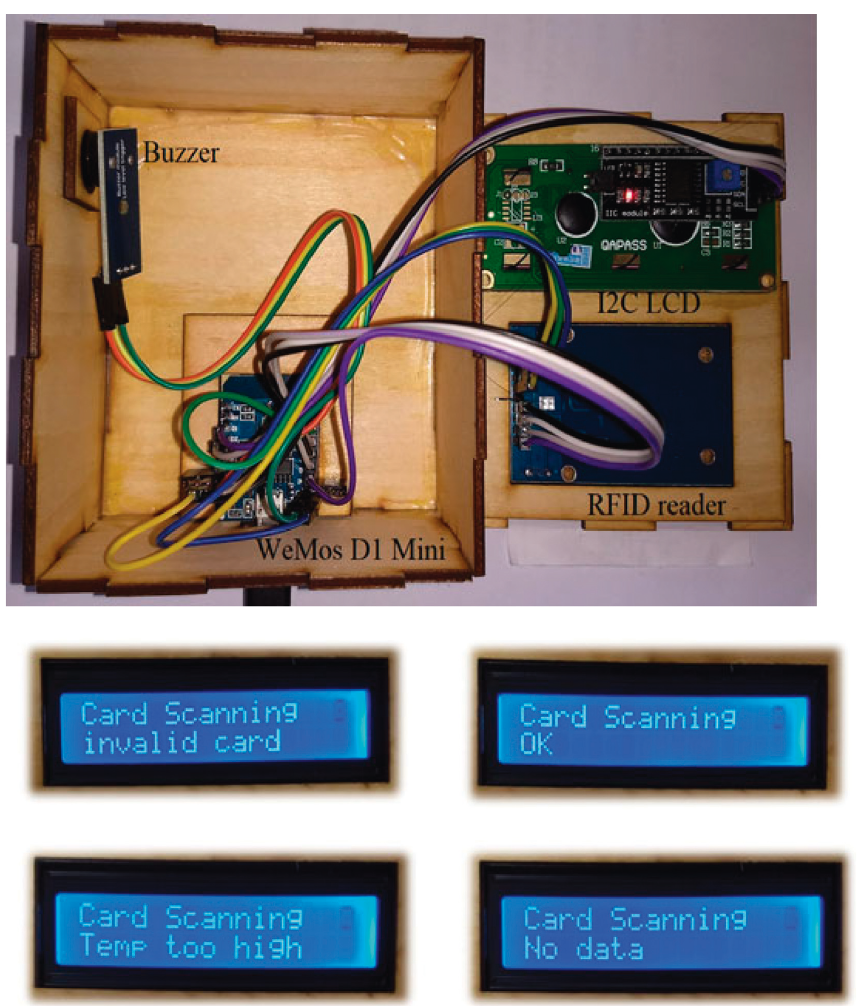
Figure 13: Card screener assembly and four possible